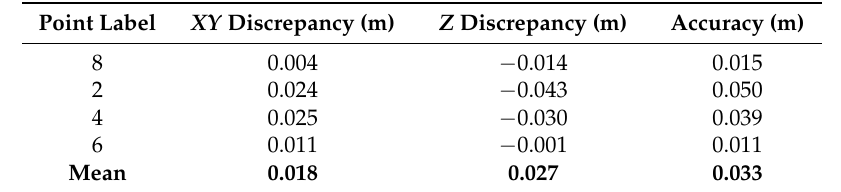
Table 3. Check points. “ XY discrepancy” is the X and Y discrepancies obtained comparing the measurements provided by the GNSS system and the coordinates measured in the point cloud for a “Check point”; “ Z discrepancy” is the Z coordinate discrepancy between coordinates measured with the GNSS system and the Z coordinate measured in the point cloud for a “Check point”; “Accuracy” is the root mean square discrepancy for X , Y , Z coordinates for a “Check point” and “Mean” implies averaging all the “Check